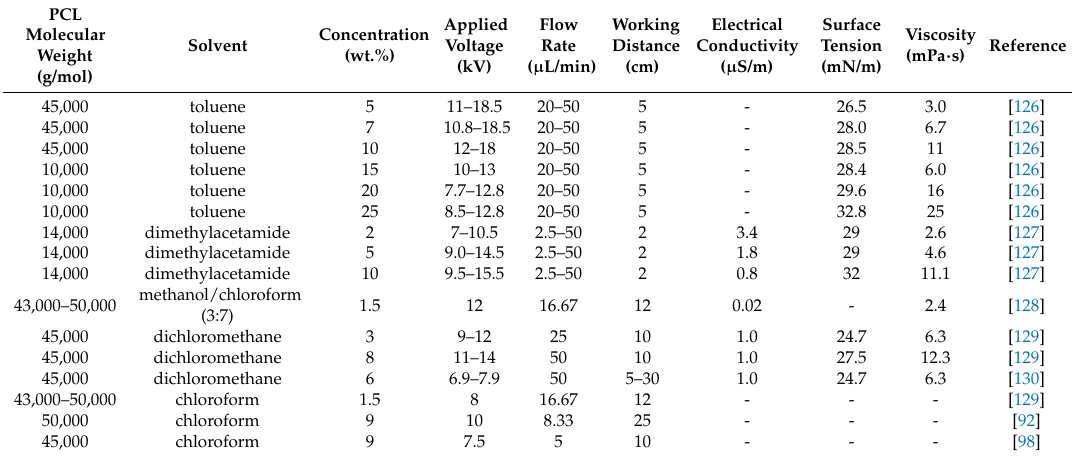
Table 5. Operating parameters value ranges to achieve cone-jet mode in the electrospraying process of